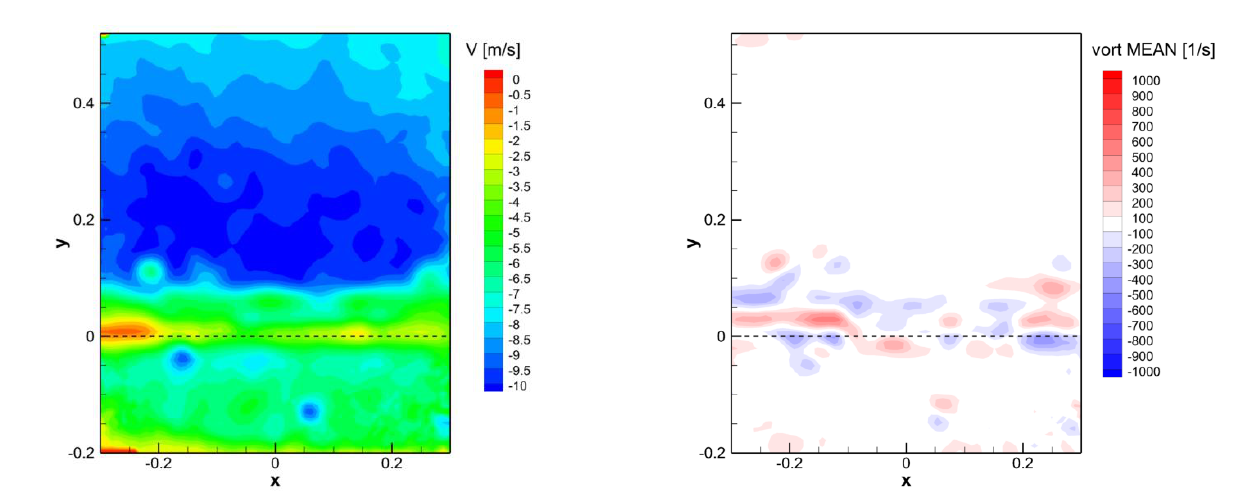
Fig. 21. Mean vorticity distribution. Re = 1.5M.